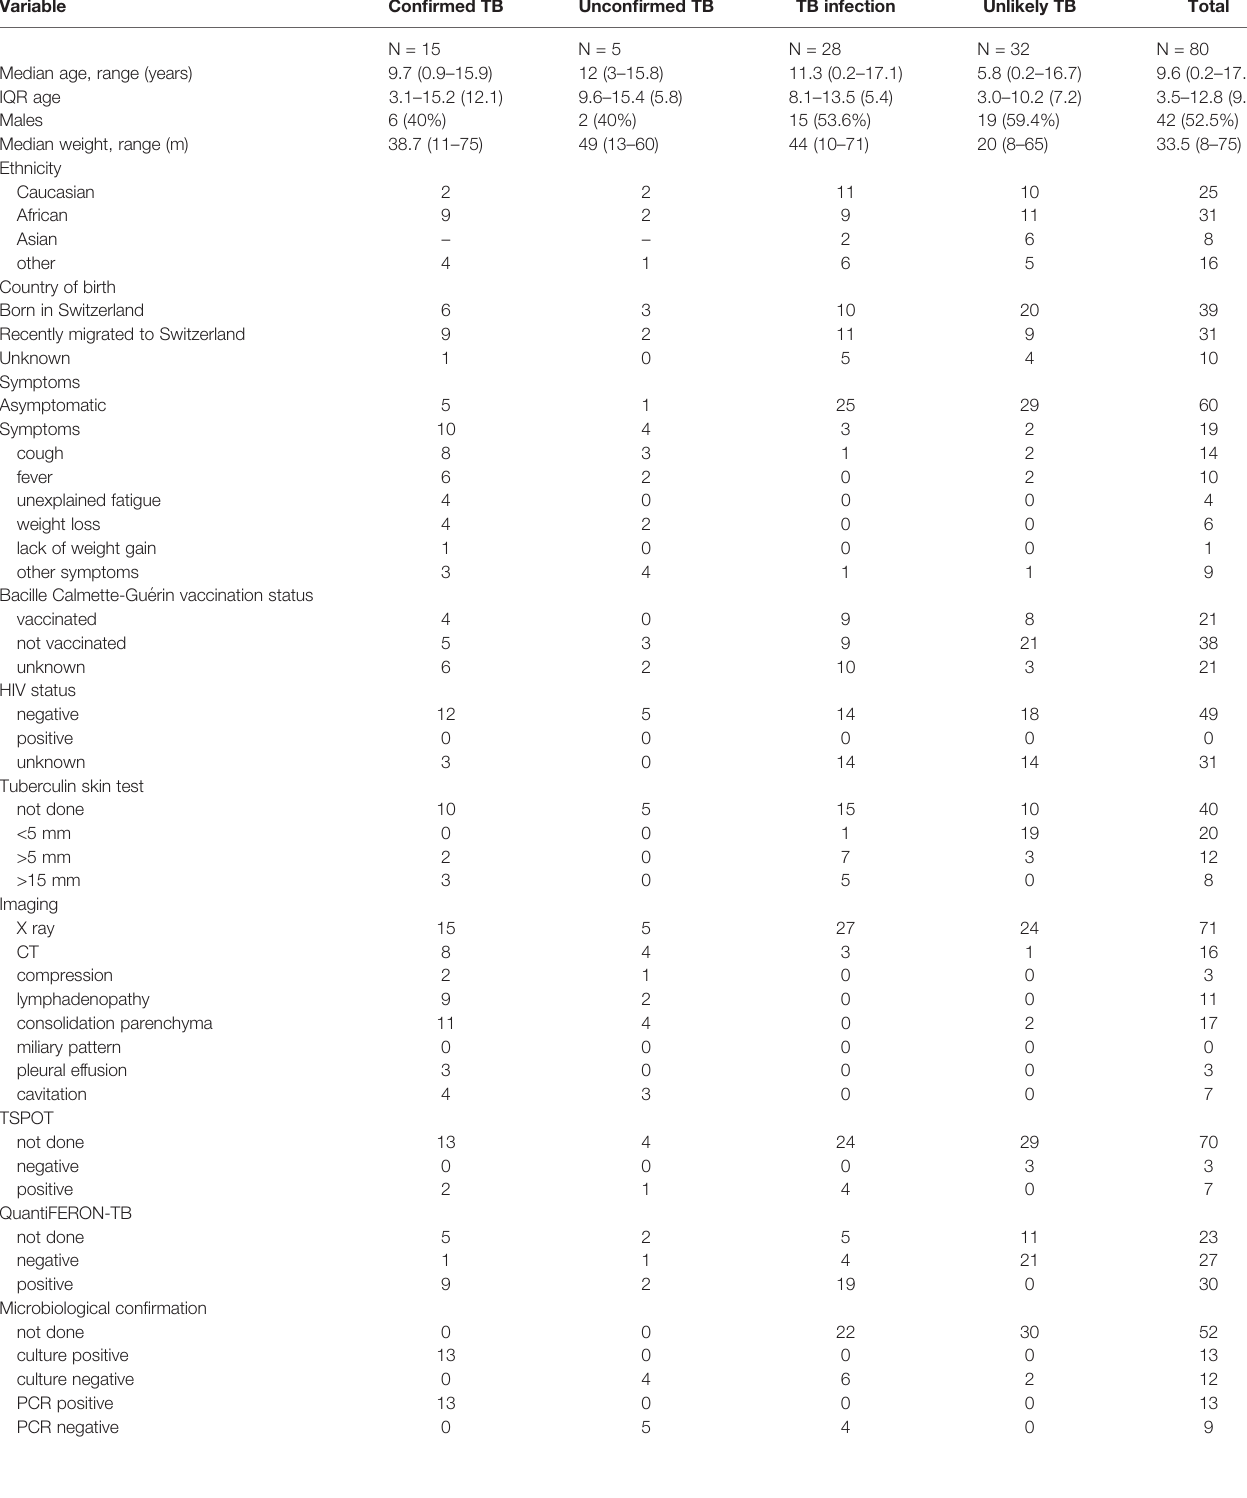
TABLE 1 | Baseline characteristics of the study population according to study